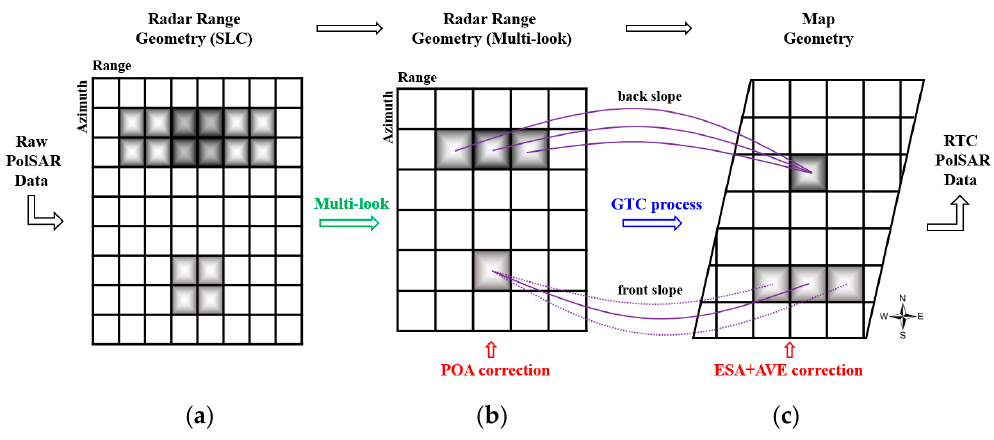
Figure 2. Geometry space of polarimetric synthetic aperture radar (PolSAR) data at different data processing steps and its topological relationships: ( a ) single-look complex (SLC) PolSAR data; ( b ) multi-look PolSAR data; ( c ) geocoded terrain corrected (GTC) processed PolSAR data (after [9]).